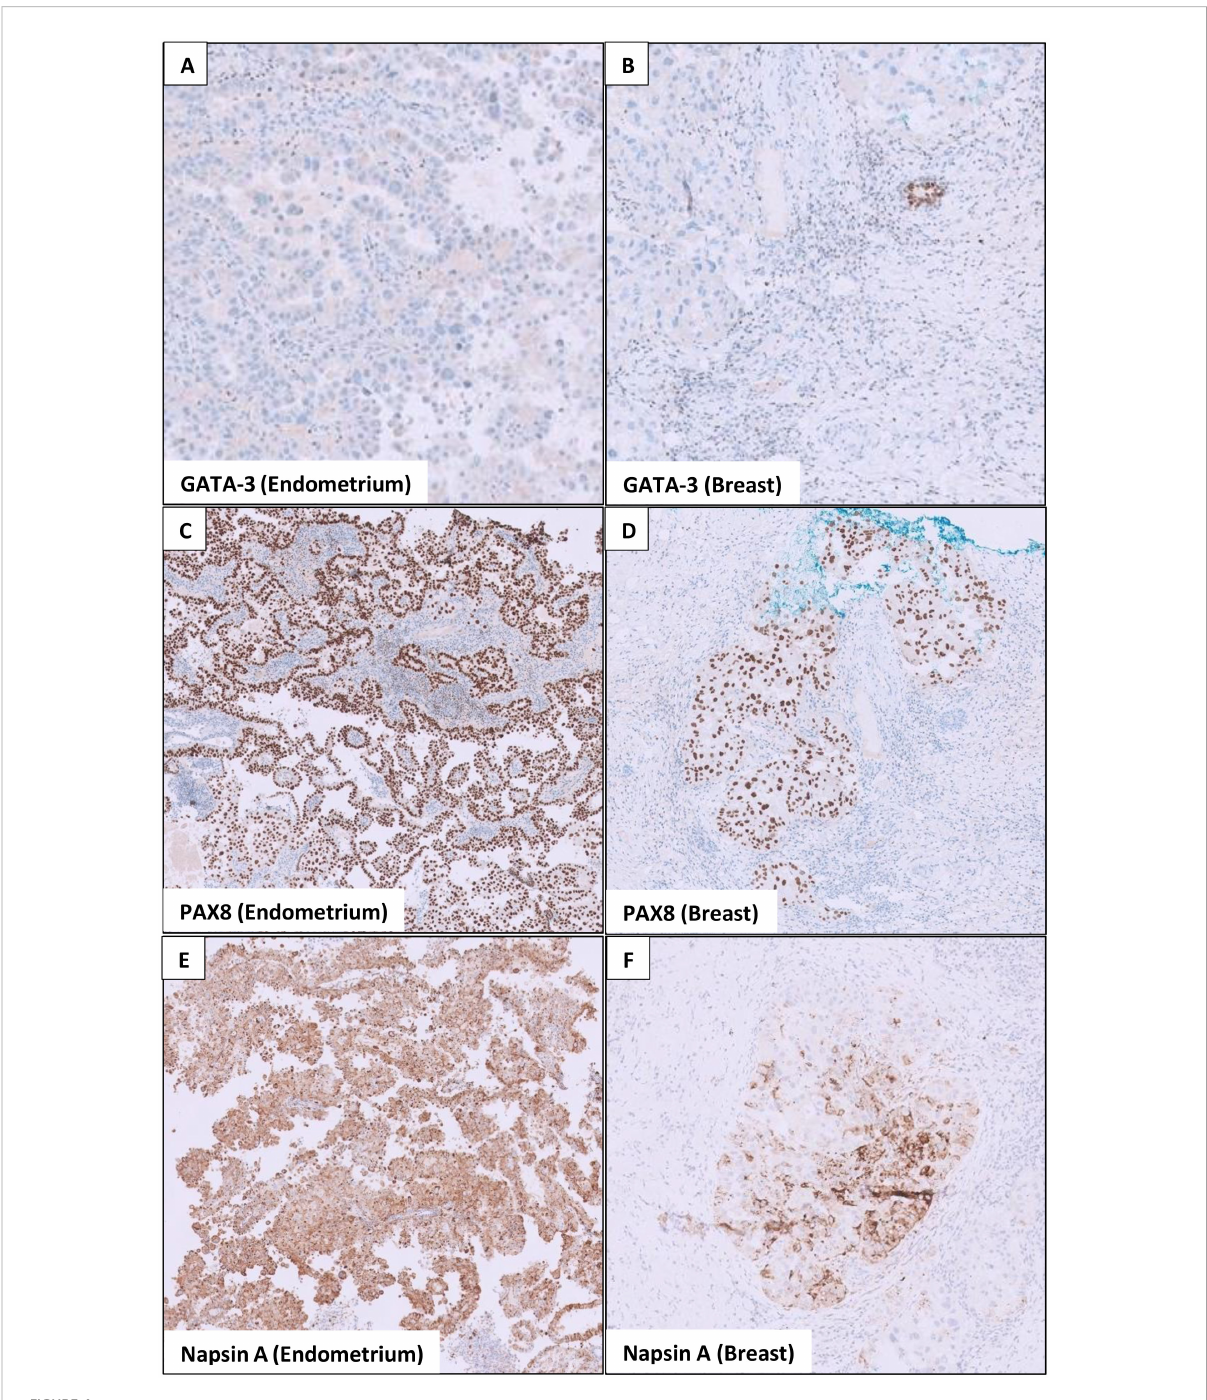
FIGURE 4 Immunohistochemical stains show similarities in the endometrial and breast tumor. (A) The endometrial tumor stains negative for GATA-3 (a breast marker). (B) Similarly, the breast tumor also stains negative for GATA-3, although the adjacent breast ducts are positive. (C, E) show that the endometrial tumor stains positive for PAX8 (marker for Müllerian tumors) and napsin A (marker for clear cell carcinoma). In (D, F) the breast tumor similarly stains positive for PAX8 and napsin A, whereas the adjacent breast tissues are